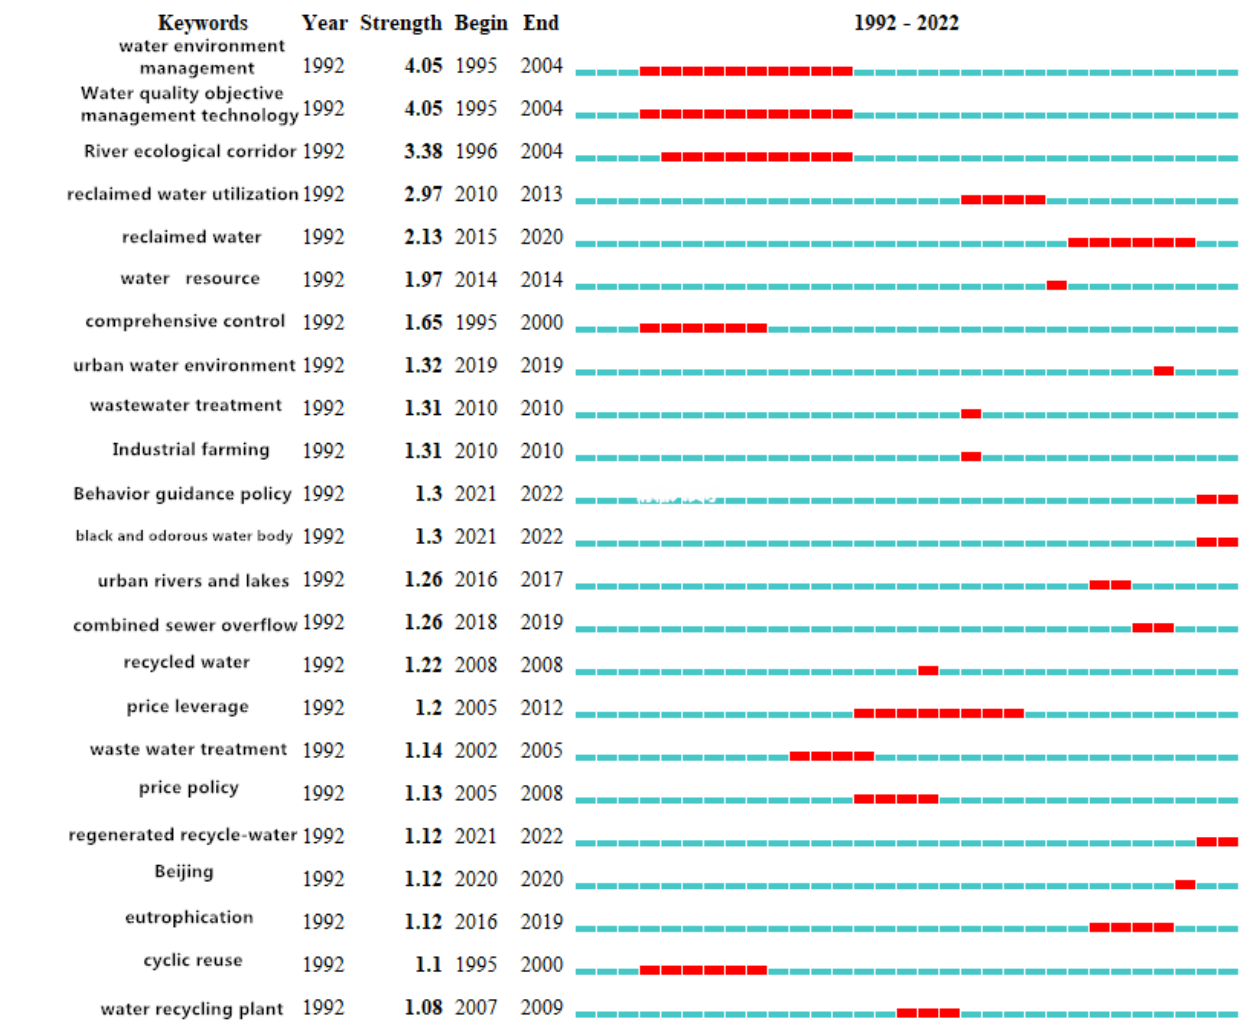
Figure 14. Keywork bursts in regenerated water utilization policy research from CNKI.